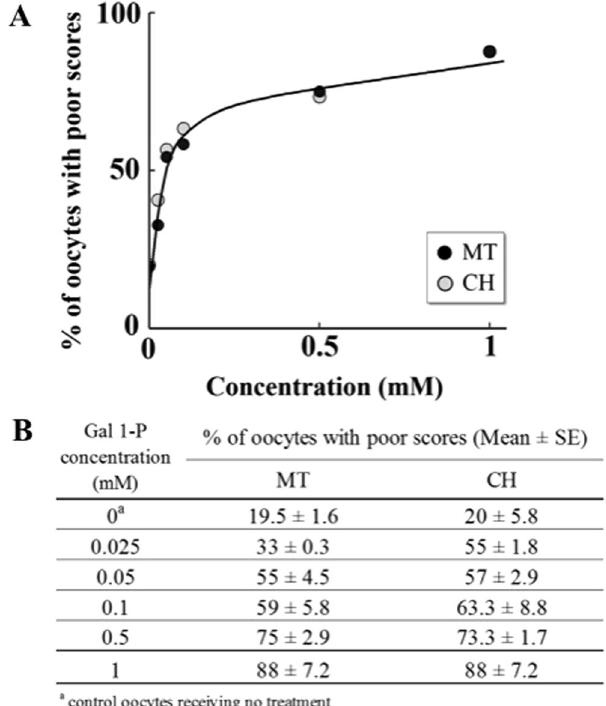
Figure 4. Concentration dependent effect of galactose 1-phosphate on oocyte quality. Percentage of oocytes with poor outcomes in MT structure and CH alignment, at 4 hours of incubation, when the oocytes without cumulus cells were incubated with increasing concentrations of galactose 1-phosphate (0.025 mM to 1 mM) {n = 10 for each concentration}, followed by indirect immunofluorescence staining. The table at the bottom presents the mean of percentage of oocytes with poor scores for each concentration with the standard error of mean.